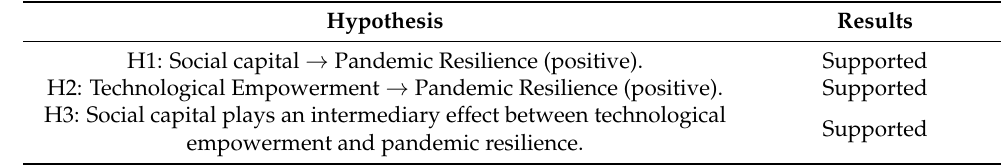
Table 8. Results of hypotheses